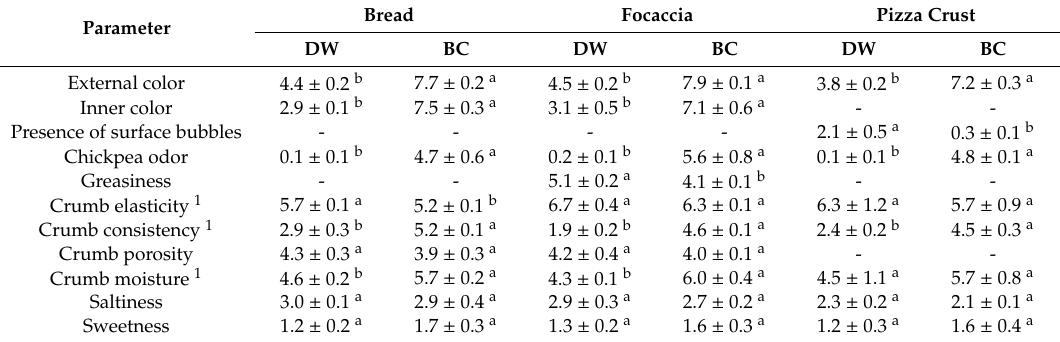
Table 10. The sensory profile of conventional durum wheat bread, focaccia, and pizza crust, and